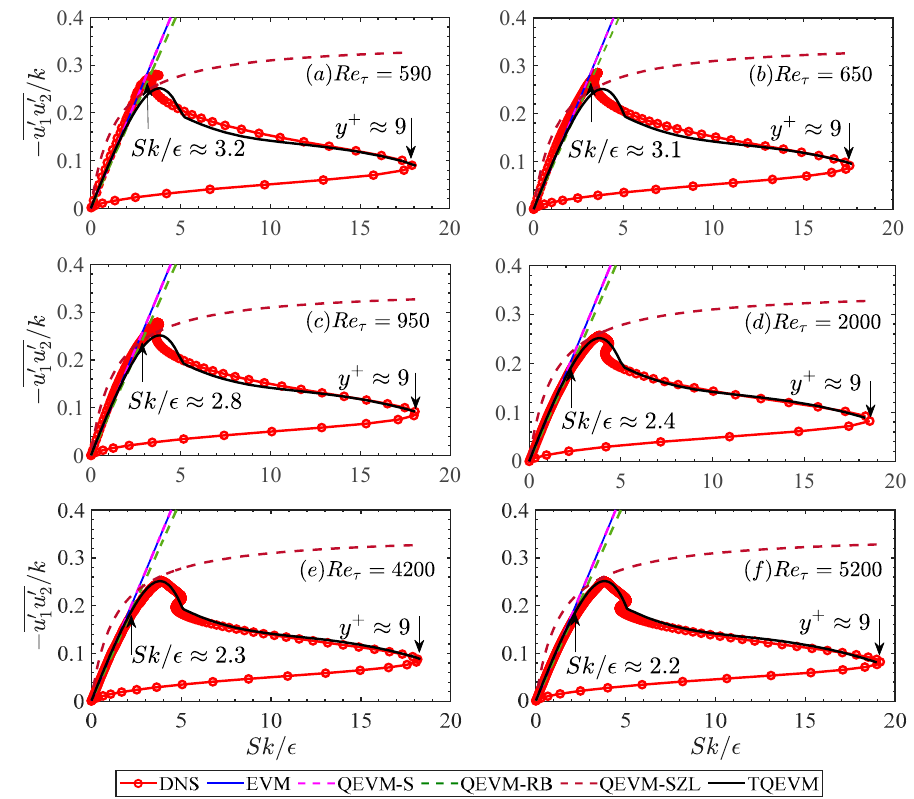
Figure 4. Dimensionless Reynolds shear stress − u (cid:48) 1 u (cid:48) 2 / k as a function of dimensionless shear parameter Sk / (cid:15) for ( a ) Re τ = 590, ( b ) Re τ = 650, ( c ) Re τ = 950, ( d ) Re τ = 2000, ( e ) Re τ = 4200, and ( f ) Re τ = 5200 predicted by DNS, EVM, QEVM-S, QEVM-RB, QEVM-SZL, and the proposed TQEVM.